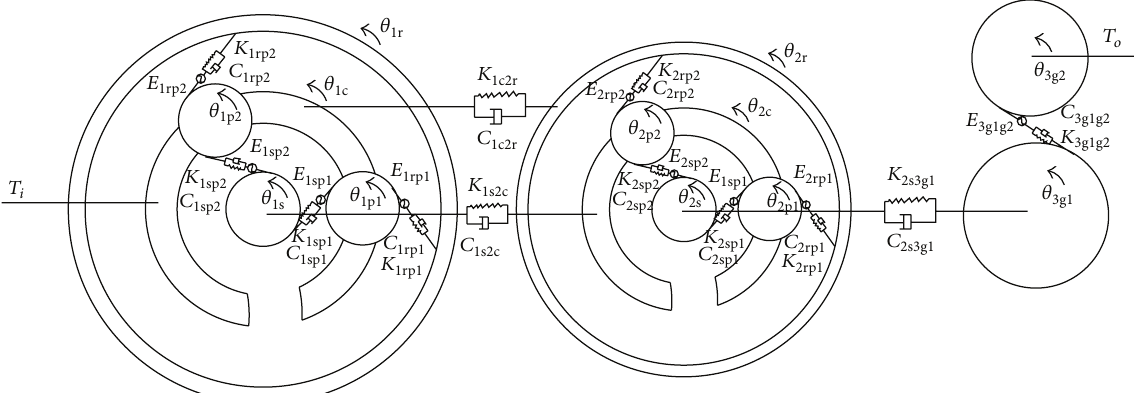
Figure 4: Dynamic model of load-split multiple-stage planetary gear train.